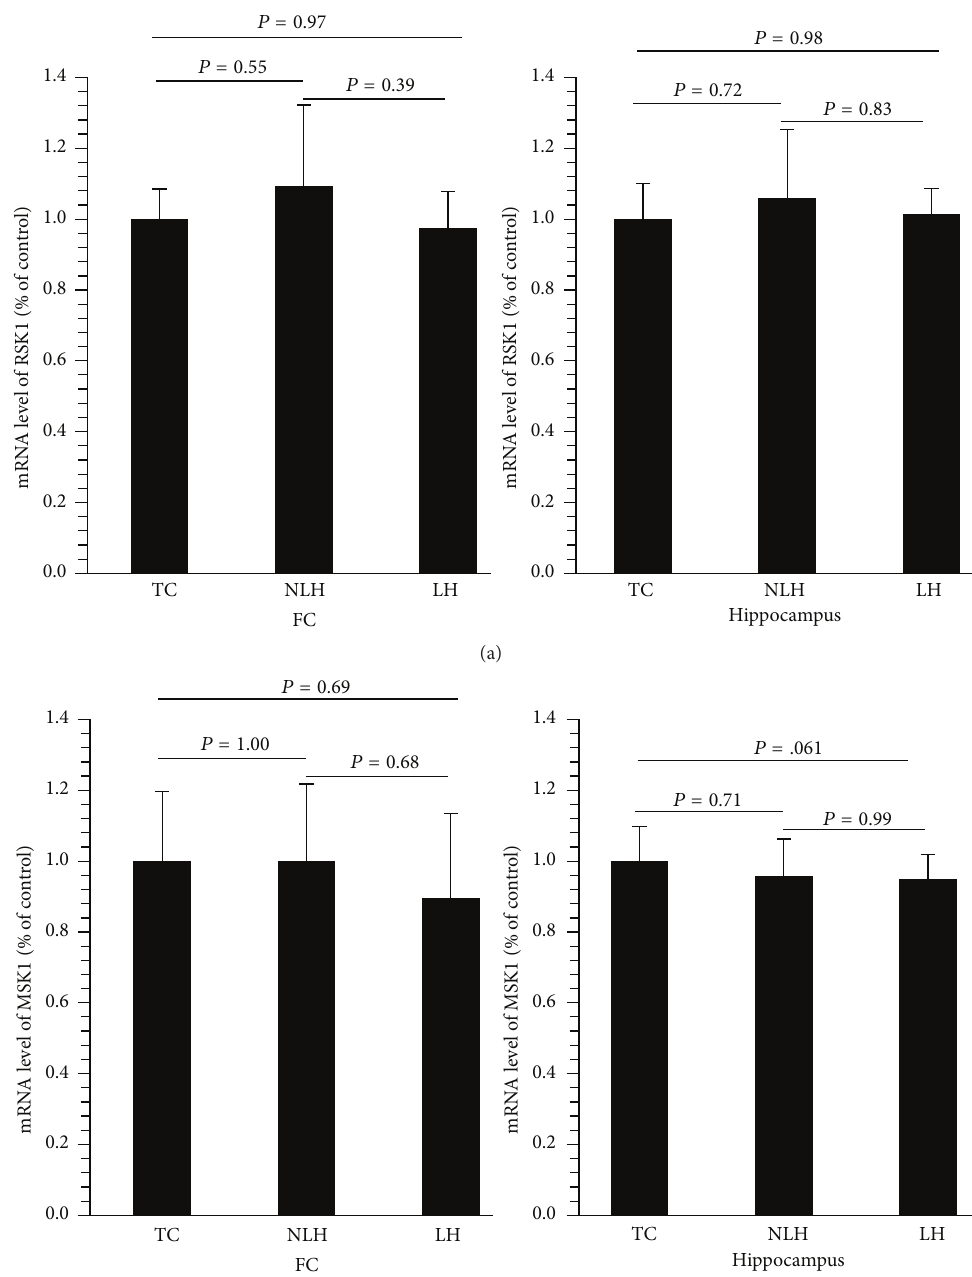
Figure 9: mRNA levels of RSK1 and MSK2 in frontal cortex (FC) (a) and hippocampus (b) of tested controls (TC), non-learned helpless (non-LH), and learned helpless (LH) rats. Data are the mean ± SD from 6 rats in each group. Overall group differences in the 3 groups are as follows. FC: df = 2, 15 , 𝐹 = 1.00 , and 𝑃 = 0.39 ; hippocampus: df = 2, 15 , 𝐹 = 0.33 , and 𝑃 = 0.72